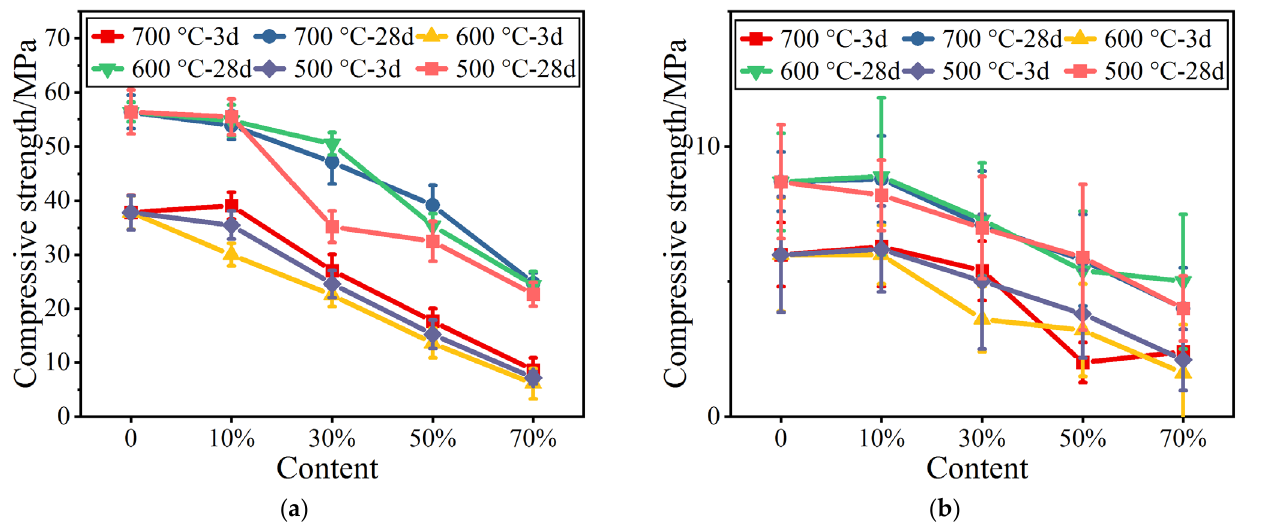
Figure 1. Mechanical strengths of calcined coal gangue . ( a ) Compressive strength. ( b ) Flexural strength.